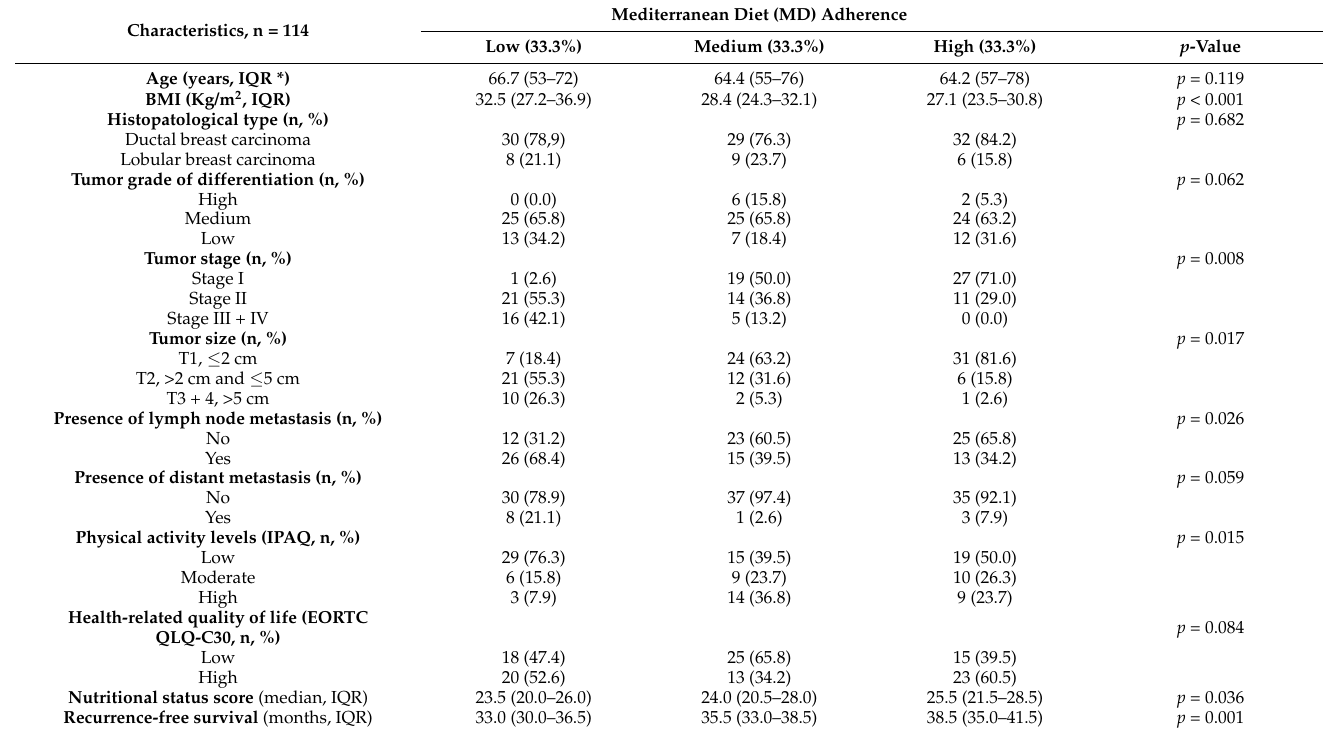
Table 1. Associations between examined characteristics and Mediterranean diet (MD)